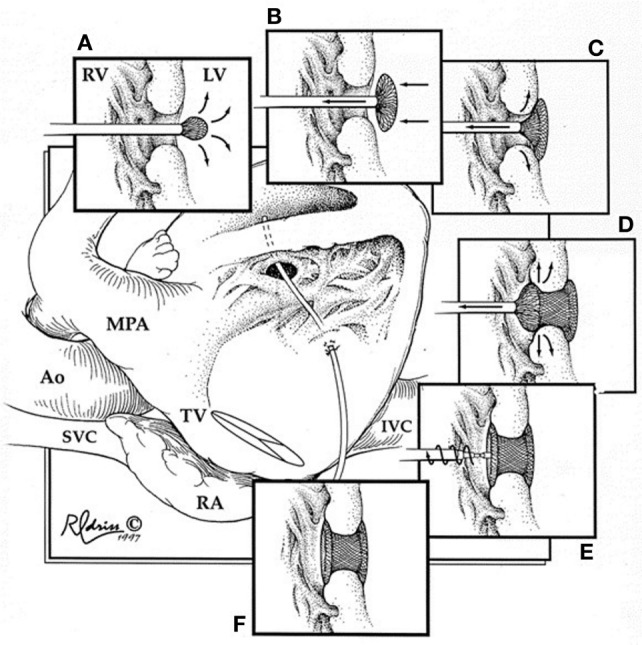
Hybrid muscular ventricular septal defect closure. Schematic diagram illustrating the steps involved in deployment of the device through the right ventricular free wall. RV, right ventricle; LV, left ventricle; MPA, main pulmonary artery; Ao, aorta; SVC, superior vena cava; TV, tricuspid valve; RA, right atrium; IVC, inferior vena cava. Reprinted with permission from publisher: Elsevier (24).